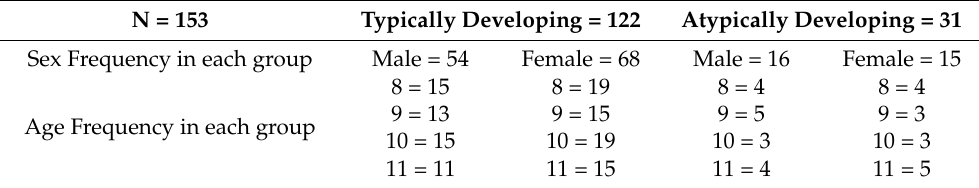
Table 1. Demographic Information of Participants. N = 153 Typically Developing =